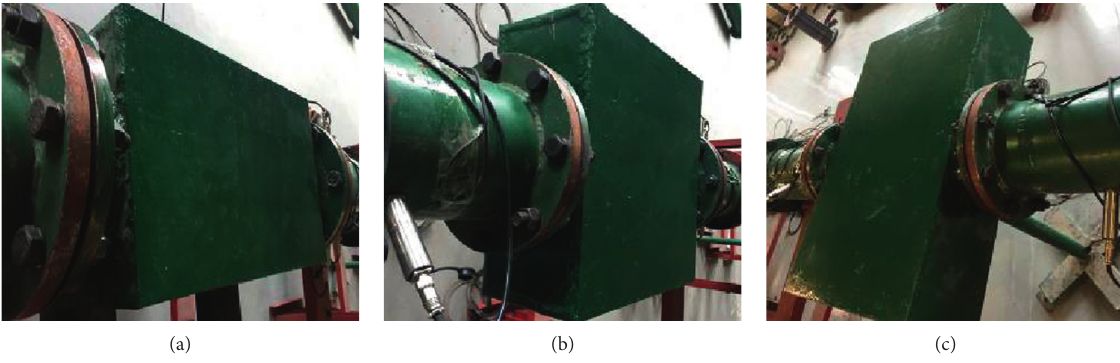
Figure 9: Photographs of different width cavities. (a) 500 ∗ 300 ∗ 200. (b) 500 ∗ 500 ∗ 200. (c) 500 ∗ 800 ∗ 200.